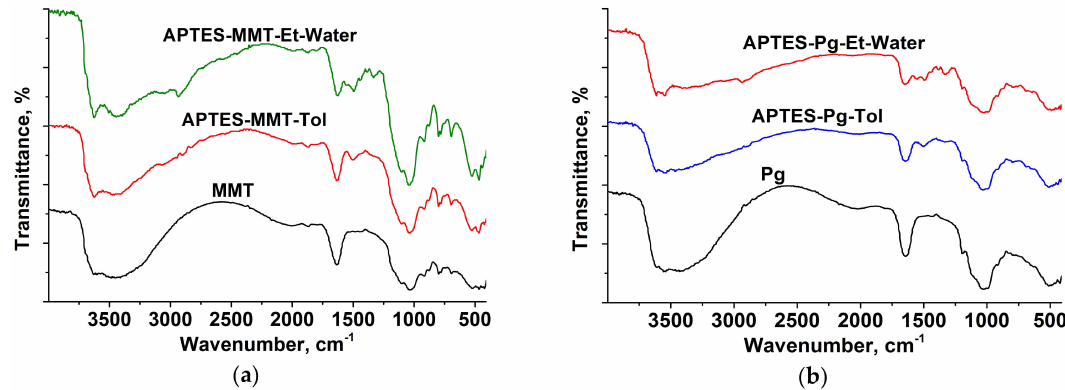
Figure 1. FTIR spectra of pristine and APTES-modified clay minerals: ( a ) montmorillonite, ( b ) palygorskite. XRD patterns of the initial and modified montmorillonite are presented in Figure 2a. The shift of basal reflection from 1.29 nm in nontreated samples to 1.6–1.7 nm in modified clays is the evidence of an increased distance between structural packets of mineral due to intercalation of APTES molecules into interlayer space. In the case of palygorskite, XRD patterns are identical for initial and treated samples, which is determined by the rigidity of this layer-ribbon silicate and the possible interaction of modifier molecules only with an external surface of mineral particles (Figure 2b).